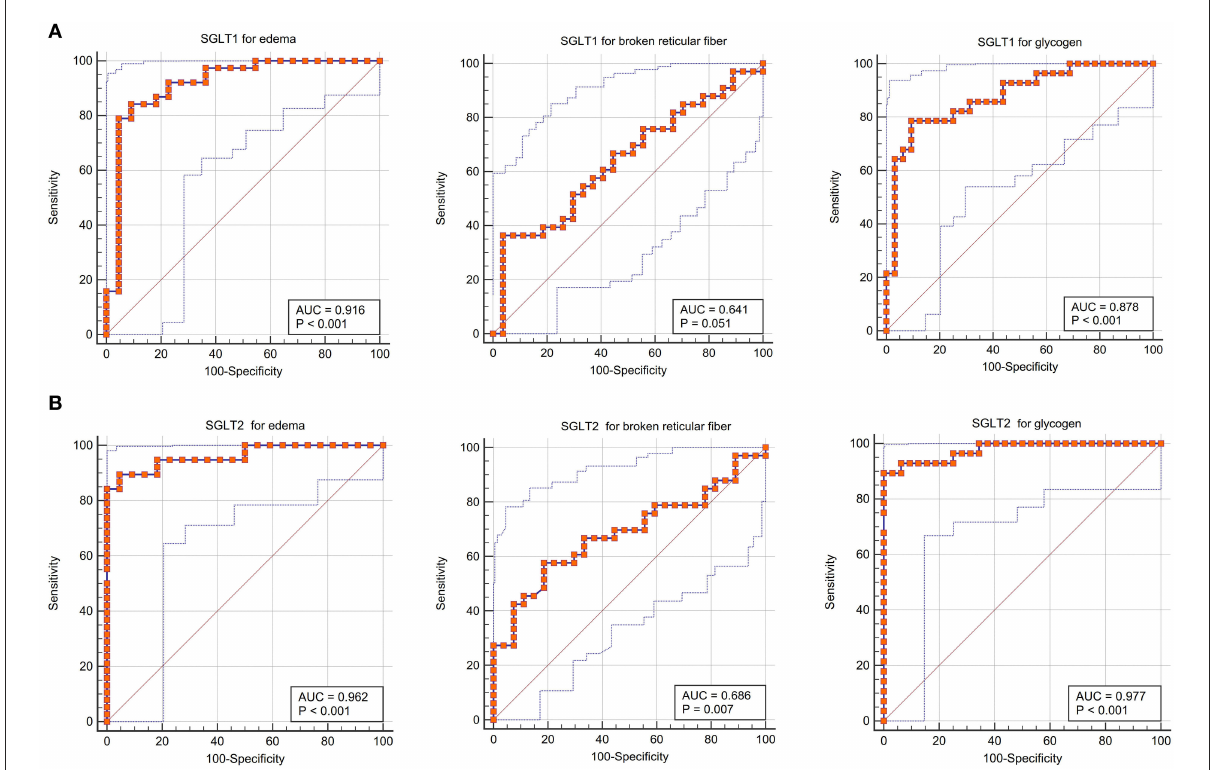
FIGURE7 Sensitivity and specificity of diagnosis of SGLT1 and SGLT2 for edema, reticular fibers, and glycogen in the kidney. (A) Receiver operating characteristic curve indicated that the expression level of SGLT1 in our experiment also could predict renal edema [area under the curve (AUC) = 0.916; P < 0.001], broken reticular fibers (AUC = 0.641, P = 0.051), and the glycogen content (AUC = 0.878, P < 0.001) sensitively and specifically. (B) Expression level of SGLT2 in our experiment also could predict renal edema (AUC = 0.962; P < 0.001), broken reticular